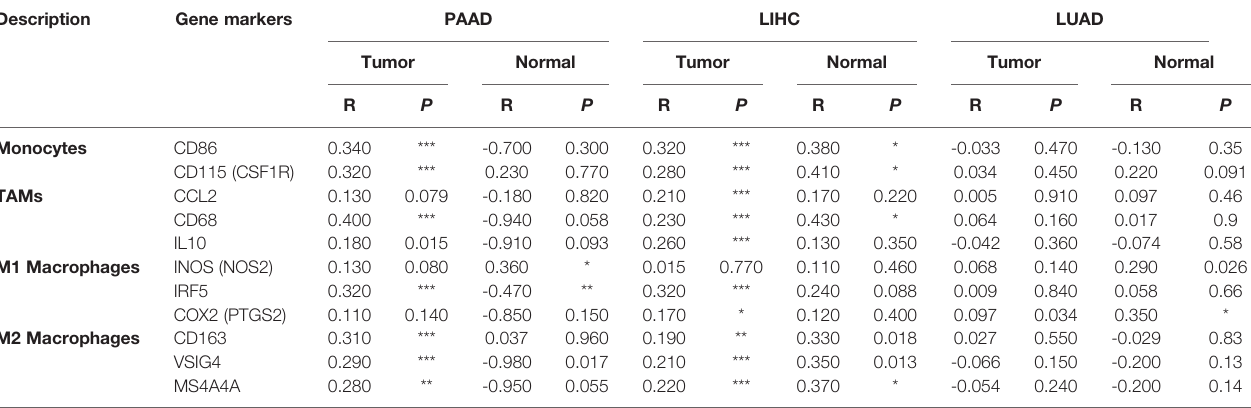
TABLE 2 | Analysis of the correlations between USP10 expression and genetic markers of monocytes and macrophages using GEPIA data.